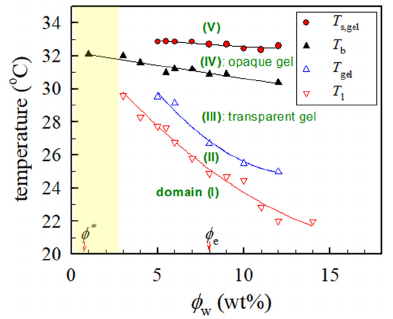
Figure 11. Phase diagram of a-PNIPAM/H 2 O binary mixtures. T 1 and T s,gel are obtained in this work from the temperature sweep test at a heating rate of 0.2 °C/min and applied frequency of 5 rad/s. T gel and T b are taken from Refs. [14,15]; T gel derived from the Winter-Chambon criterion and T b de- rived from the extrapolated T cp at a zero-heating rate. The overlap concentration ϕ * is ~0.6 wt% and the entanglement concentration ϕ e is ~8